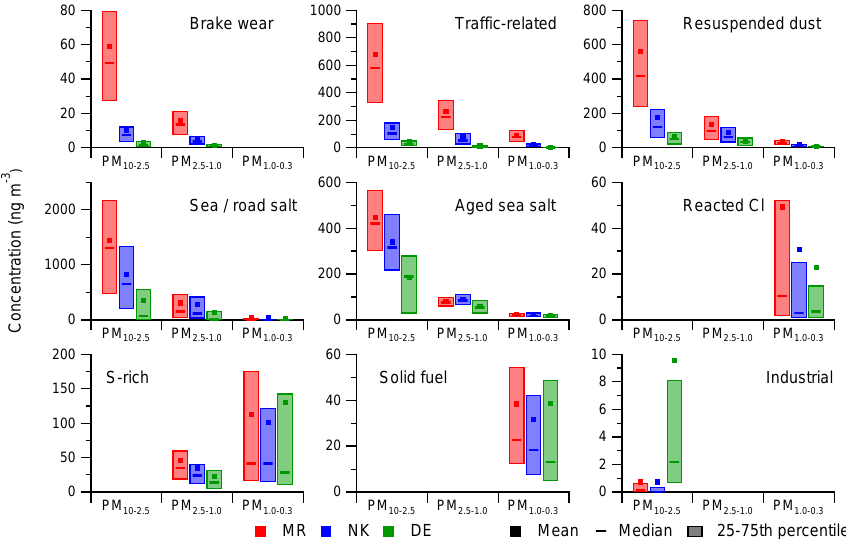
Figure 15. Mean, median and 25–75th percentile concentrations of the nine different ME-2 factor time series at MR, NK and DE for PM 10–2 . 5 , PM 2 . 5–1 . 0 and PM 1 . 0–0 . 3 . Note that not all factors are retrieved in all size